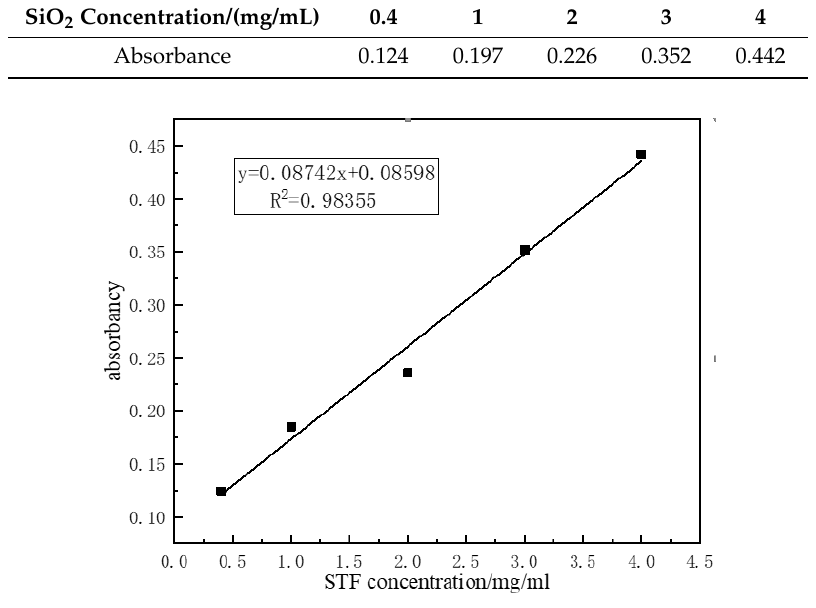
Table 1. Relation between concentration of silica and absorbance of STF.